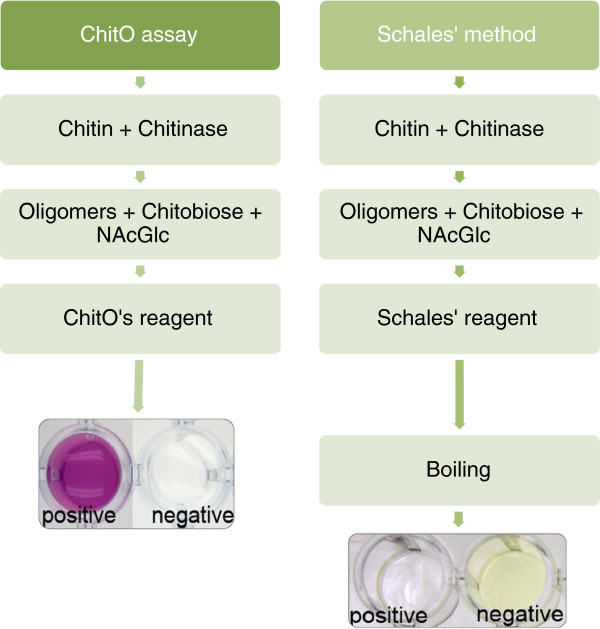
Comparison of the outline of the Schales’ procedure and the developed ChitO-based assay. Schales’ reagent, starting with a yellow color, reacts with the reducing sugars obtained from chitinase activity and after boiling a fading of the yellow color can be monitored at 420 nm. In the ChitO-based assay, the development of the pink product does not require any boiling step and is visible in a short time, depending on the concentration of oligomers in the reaction and the amount of ChitO used. Images edited to improve contrast. ChitO, chito-oligosaccharide oxidase. NAcGlc, N-acetyl-D-glucosamine.